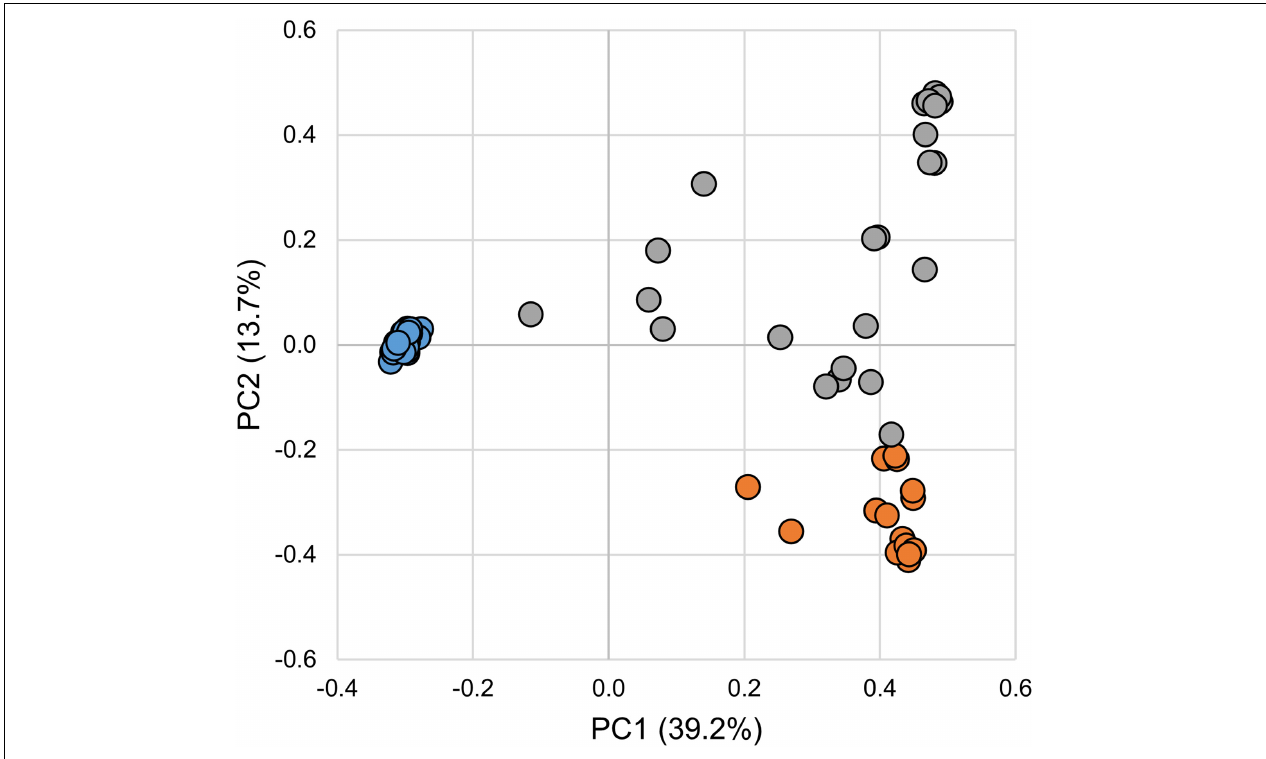
FIGURE 1 | Principal coordinates analysis of microbial communities associated with larval, parasitic, and adult sea lamprey ( Petromyzon marinus ). Each symbol represents one sample. Legend: larval (blue), parasitic (orange), and adult (gray).